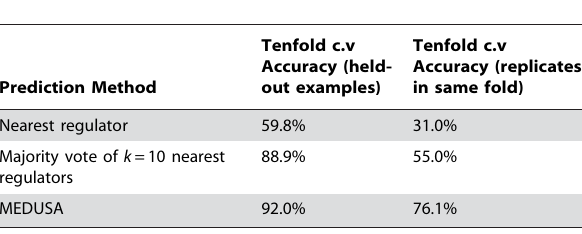
Table 1. Tenfold cross-validation accuracy for nearest- regulator method and MEDUSA, with and without grouping replicate examples within a